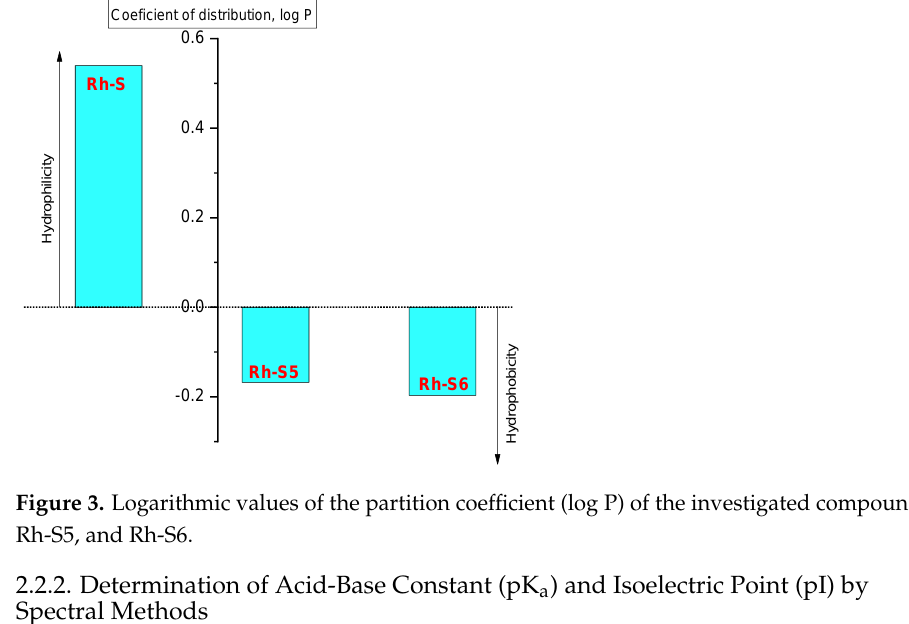
Figure 2. Morphological images (SEM) of the obtained rhodamine derivatives: ( a ) Rh-S, ( b ) Rh-S5, and ( c ) Rh-S6.